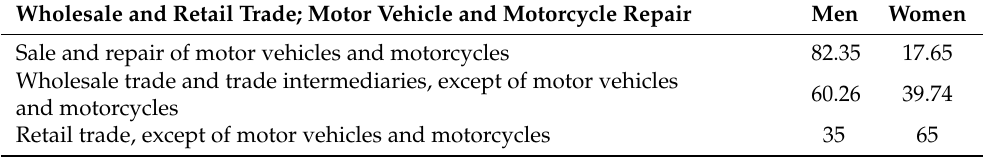
Table 5. Percentage distribution of employment by sectors in the activity branches wholesale and retail trade, and motor vehicle and motorcycle repair.